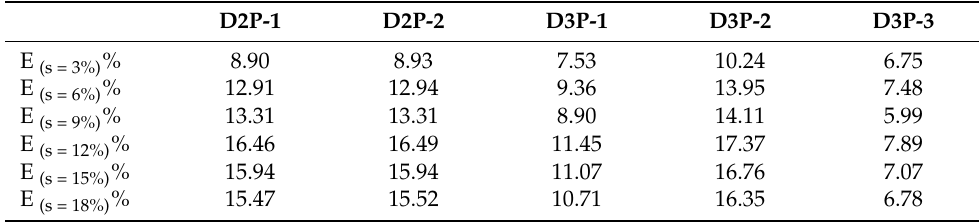
Table 4. Mean Absolute Percentage Error on peak